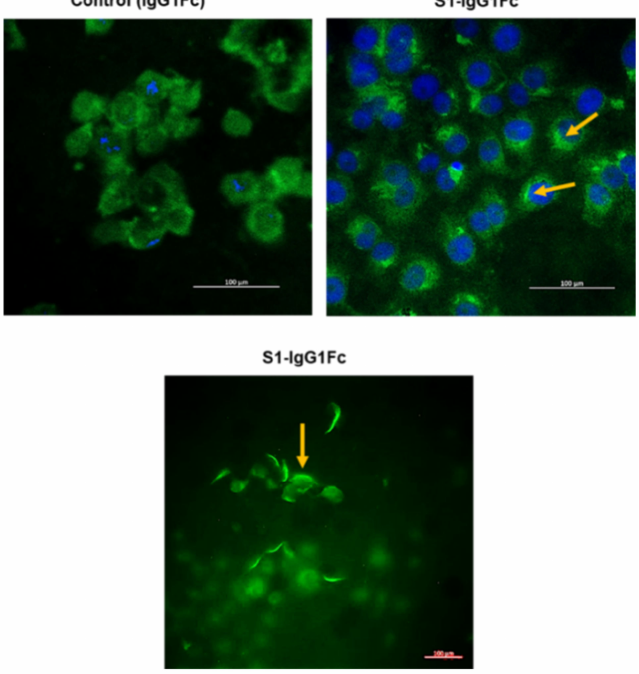
Figure 2. Binding of S1-spike-conjugated IgG1 Fc fragment to Vero E6 cells. Spike protein, specifically the S1 component, mediates the binding of SARS-CoV-2 to the cell membrane via angiotensin- converting enzyme 2 (ACE II). Binding of S1 Fc-GFP and Fc-GFP (with no S1 component) to Vero E6 cells, as visualized by a Zeiss Airyscan microscope (Section 7.2), shows significant and specific binding of S1 Fc-GFP beads to Vero E6 cells. The top panels were performed in the presence of DAPI nuclear stain. The bottom panel depicts the binding of spike protein (S1 Fc-GFP) to Vero 6 cells in the absence of DAPI nuclear stain. These studies clearly indicate that the SARS-CoV-2 spike protein can directly bind with the kidney epithelial Vero 6 cells. The orange arrows indicate specific S1 Fc-GFP signal. ( Unpublished data from the author’s laboratory